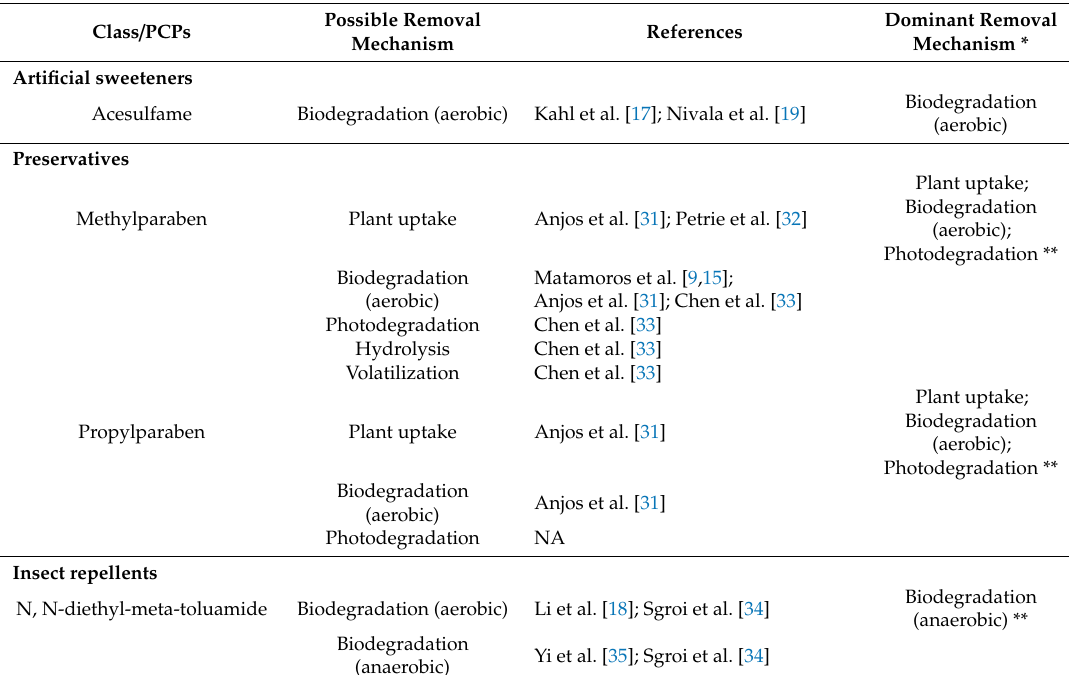
Table 4. Removal mechanisms of 15 widely studied PCPs in CWs.